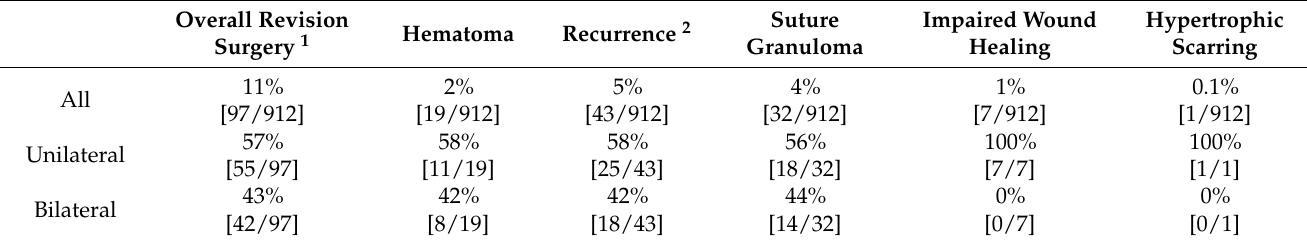
Table 1. Major complications requiring revision surgery following primary ventral otoplasty according to the Lemperle technique ( n =